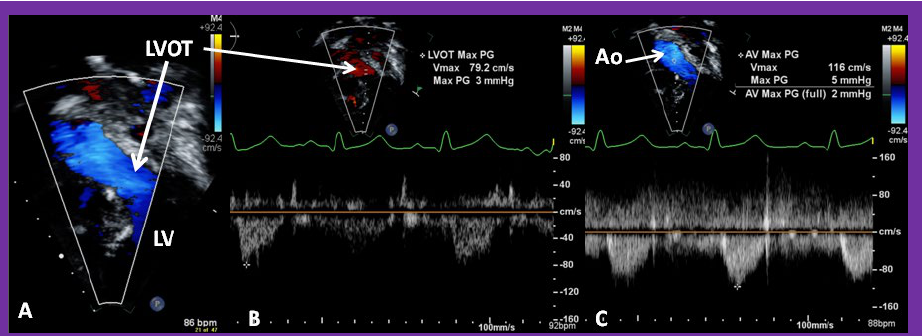
Figure 45. Selected video frame from an apical four-chamber view demonstrating that there is no evidence for left ventricular outflow tract (LVOT) obstruction in the patient shown in Figure 43. Note laminar flow across the LVOT in ( A ) and low Doppler flow velocities across the LVOT ( B ) and aorta (Ao) ( C ). LV, left ventricle.